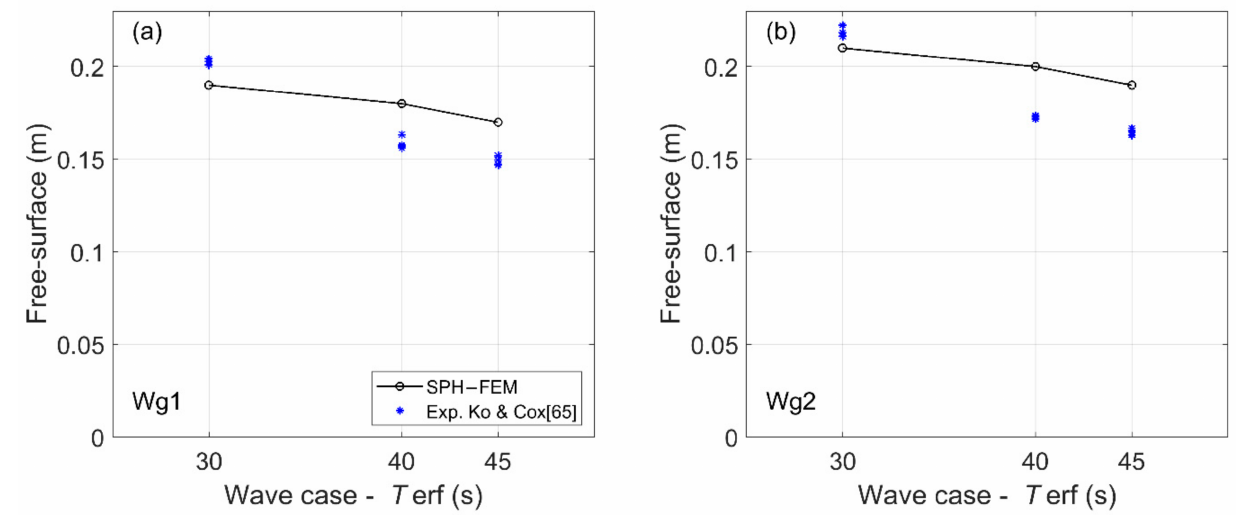
Figure 4. Maximum free-surface values of experiments [65] and numerical simulations for h 1 = 2.496 m, and three wave cases with T erf = 30, 40 and 45 s.